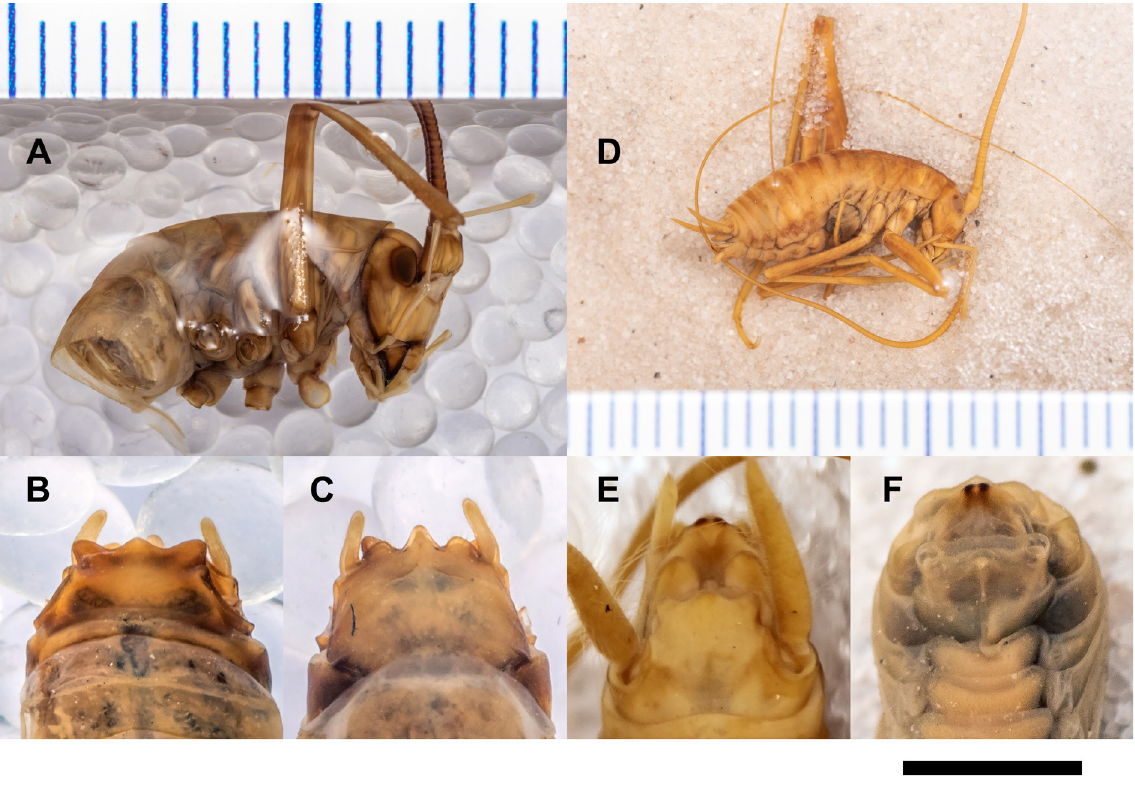
Fig. 3. Pleioplectron simplex Hutton, 1896, type specimens. A–C . Lectotype, ♂ (CMNZ 000280). A . Lateral view. B . Terminalia, dorsal view. C . Terminalia, ventral view. D–E . Paratype of Pleio- plectron pectinatum Hutton, 1896, ♂ (CMNZ 000266a). D . Lateral view. E . Terminalia, dorsal view. F . Holotype of Pleioplectron pectinatum Hutton, 1896, ♂ (CMNZ 000266), terminalia, ventral view. Scale bar = 2 mm (applies to B–C, E–F